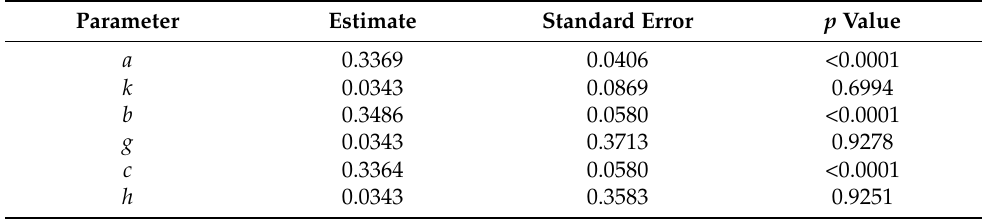
Table 2. Parameter estimates, standard errors and p values of the modified Henderson and Pabis equation [Equation (6)] to the data shown in Figure 4.